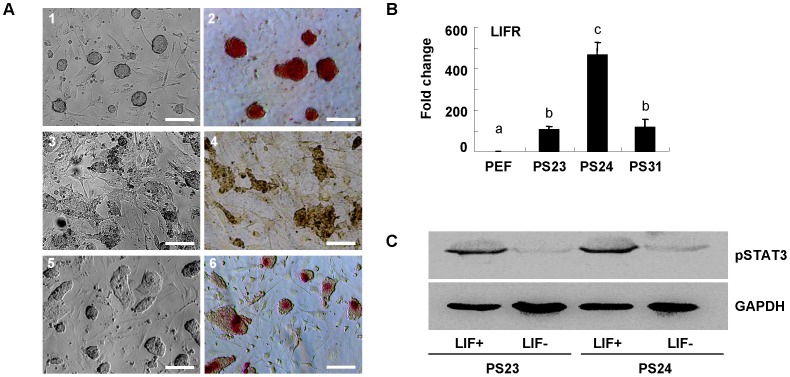
The leukemia inhibitory factor suppresses the spontaneous differentiation of piPS cells.A, The porcine PS24 cells were cultured in media with LIF and bFGF (1), without LIF (3) or without bFGF (5), respectively. The alkaline phosphatase activity was detected in above culture condition (2, 4, 6). Scale bars, 100 µm. B, The quantitative RT-PCR assay was conducted to detect the expression of LIF receptor (LIFR) in piPS cell lines. Data indicate mean ± SD (n = 3). Different letters (a, b, c) indicate significantly different between two groups, p<0.01 by Student’s t test. C, p-STAT3 protein level was investigated by Western blotting to reveal the signal pathway after the LIF treatment. GAPDH was used as an internal control.